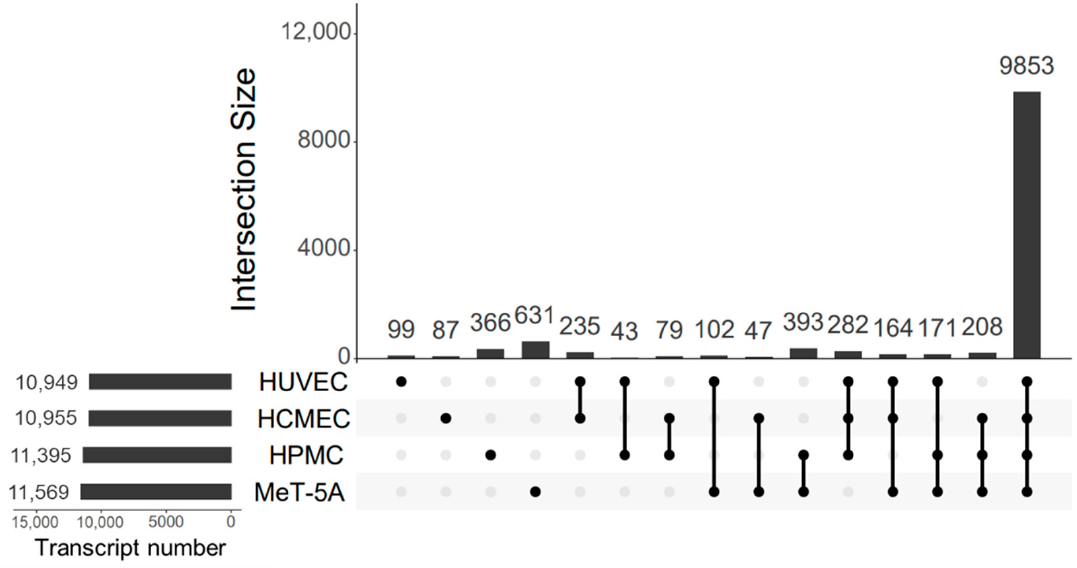
Figure 1. Identified protein-coding transcripts and their presence in studied cell lines. From a total of 12,760, 9853 transcripts were shared between all cell lines, 366, 631, 99 and 87 transcripts were HPMC-, MeT-5A-, HUVEC- and 87 HCMEC-specific, respectively.